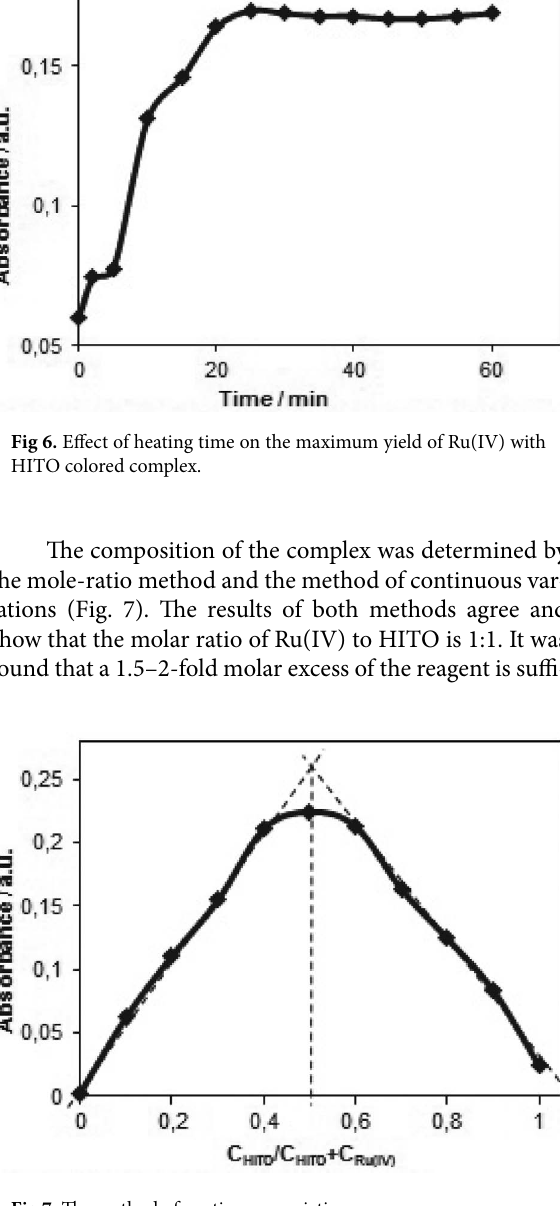
Tymoshuk et al.: Spectrophotometric Determination of Ru(IV) ...